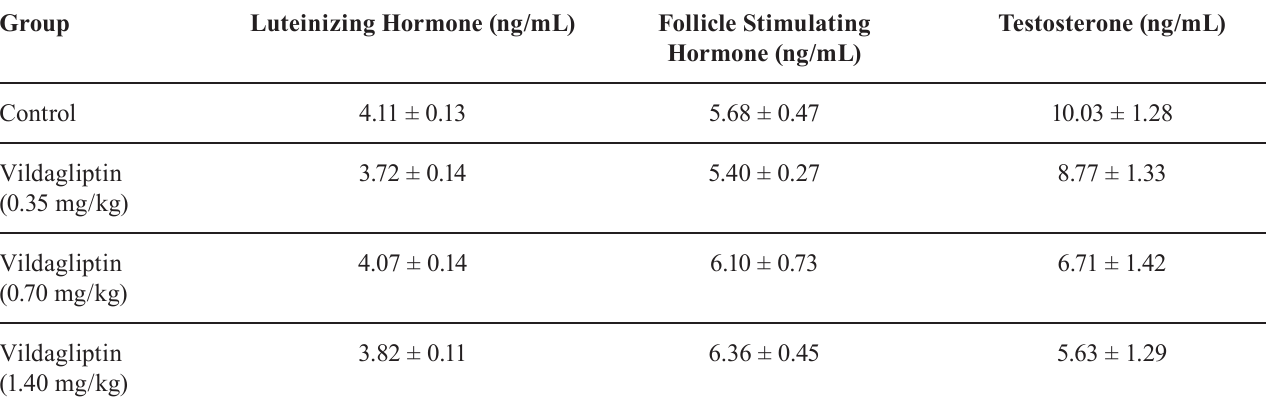
TABLE III – Effect of vildagliptin on reproductive hormones of Wistar rats (Experimental)